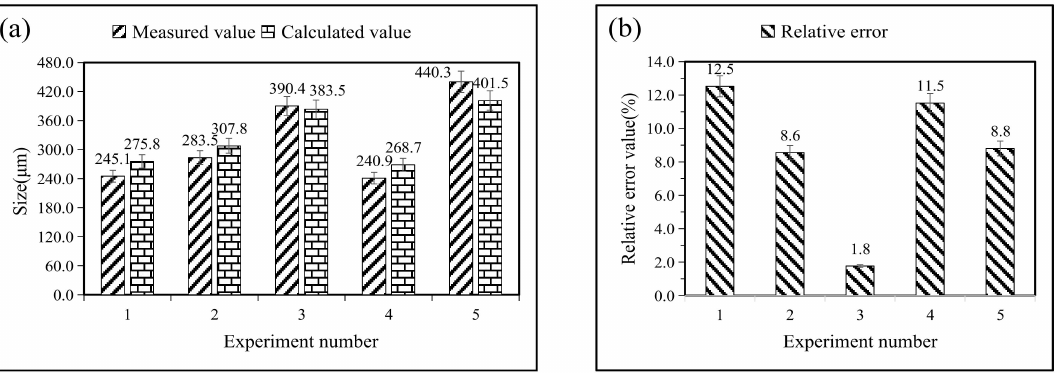
Figure 14. Error verification of Equation (10) (( a ). comparison of measureed value and calculated value; ( b ). corresponding relative